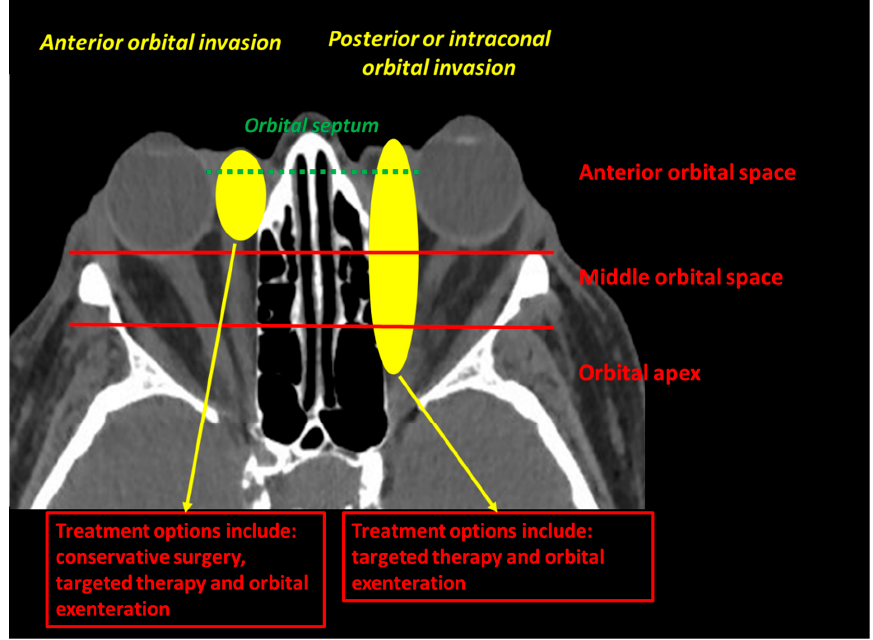
Figure 7. Current treatment options for locally advanced BCC invading the anterior orbit versus the middle/posterior orbit. Targeted therapies might be used to treat both posteriorly located and intraconal orbital BCC.